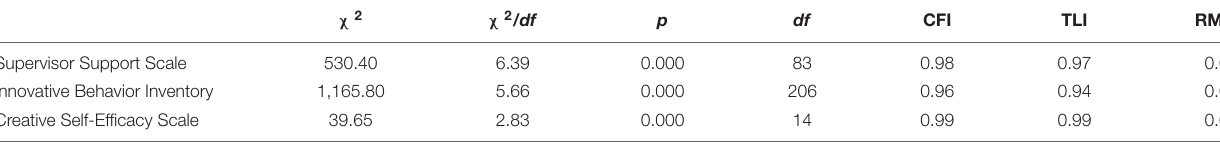
TABLE 1 | Confirmatory factor analysis results for the scales ( N = 996).